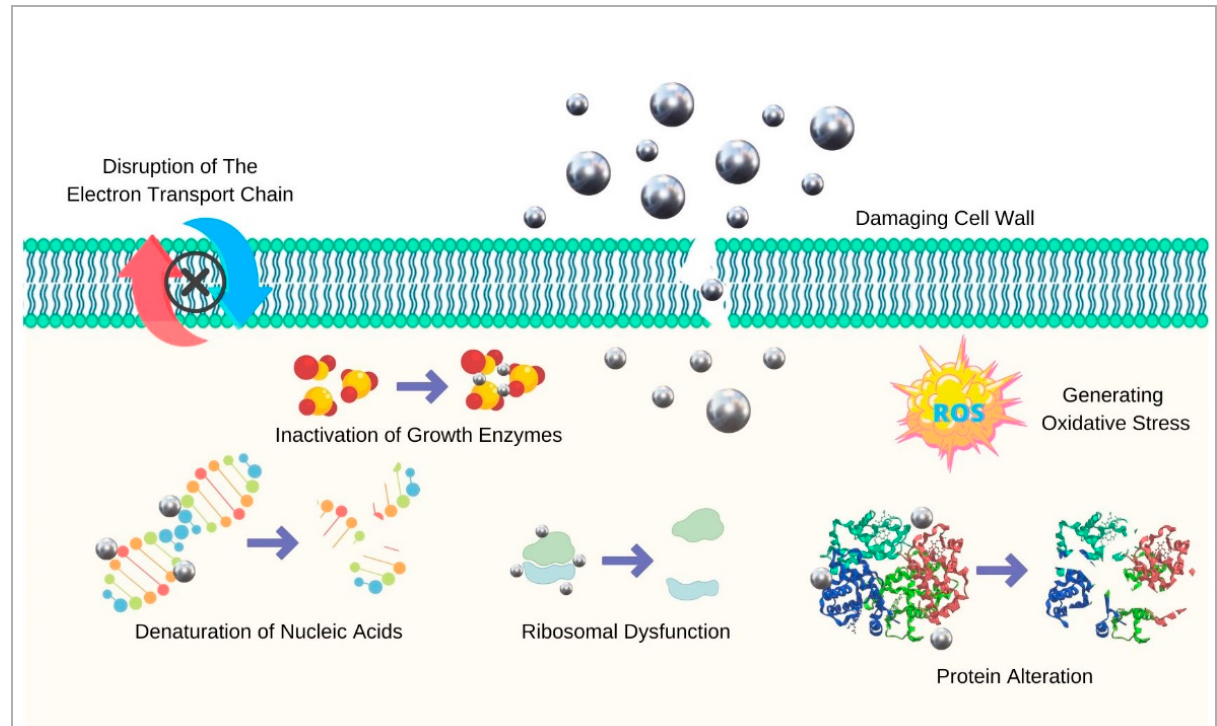
Figure 2. Antimicrobial mechanisms of silver nanoparticles.